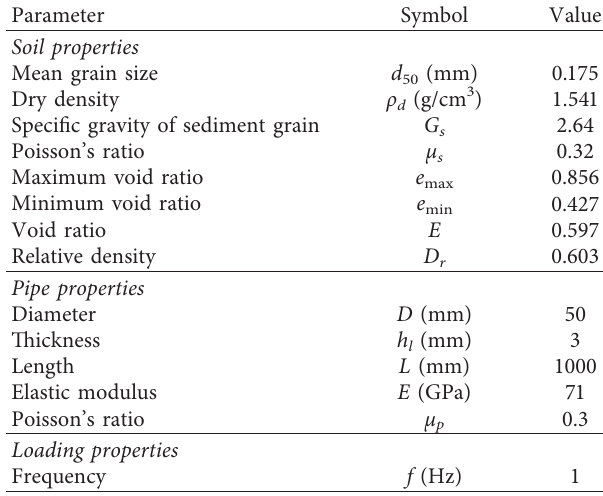
Table 2: Model test